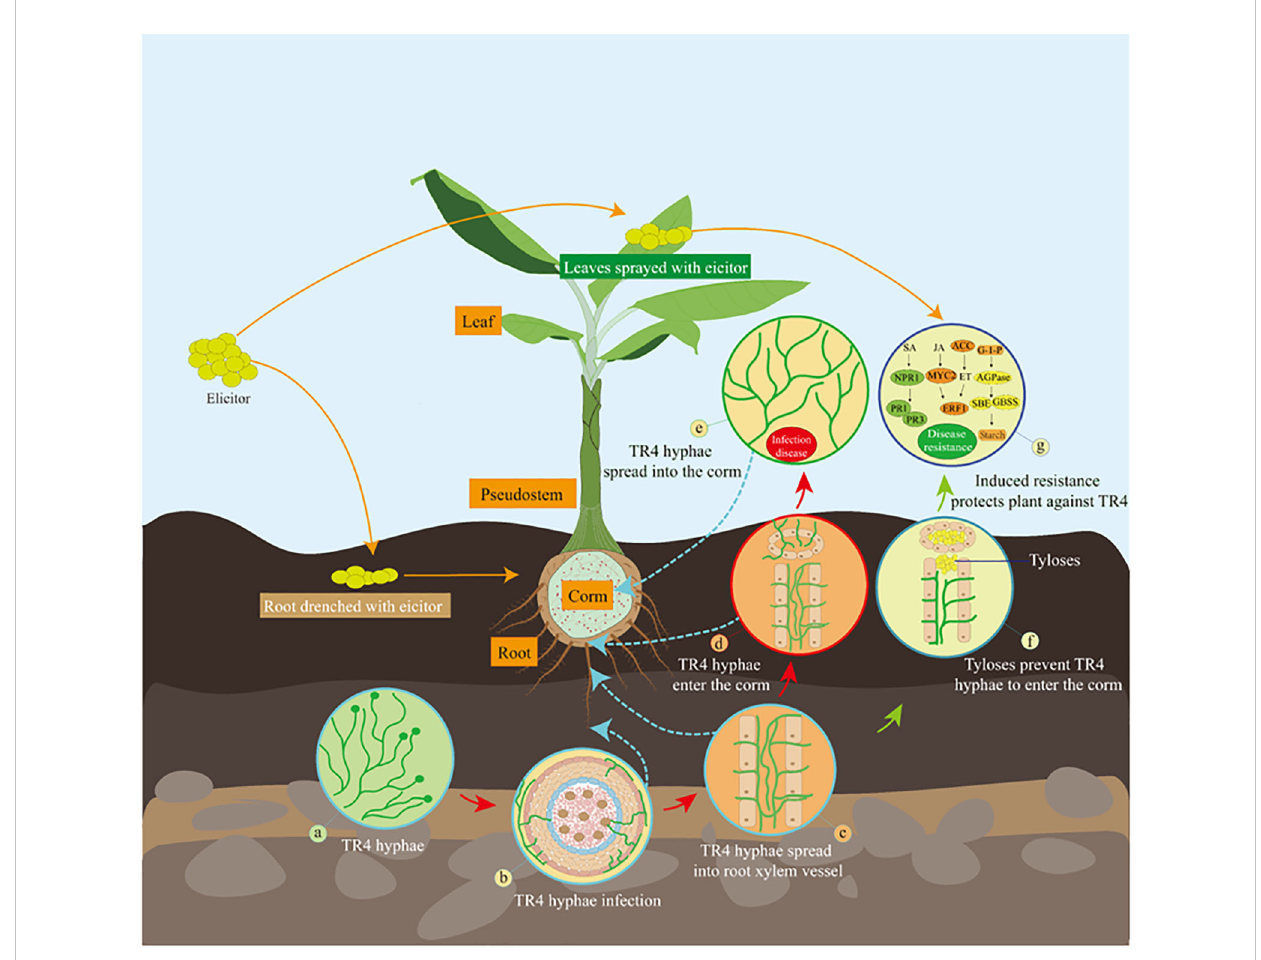
FIGURE 1 Scheme illustrating that isotianil-induced multi-resistance in bananas to prevent TR4 infection. (A) TR4 hyphae in the soil; (B) TR4 hyphae are accumulated in the rhizosphere and infestation into the plant; (C) TR4 hyphae enter plant root xylem vessel and spread further; (D) TR4 hyphae spread into the xylem vessel that connects the root to the corm; (E) TR4 hyphae spread into the corm and multiplies; (F) TR4 hyphae is blocked to enter the corm by elicitor -induced tyloses in the xylem vessel connecting the root to the corm; (G) After elicitor applicated plants by drenching roots or spraying leaves, multiple defense systems in the banana plant are activated to prevent further spread of TR4 in the corm. SA, salicylic acid; NPR1 , nonexpressorofpathogenesis-relatedgenes1; PR1 , pathogenesis-related 1 genes; PR3 , pathogenesis-related 3 genes; JA, jasmonic acid; MYC2 , basic helix-loop-helix transcription factor; ERF1 , ethylene response factor 1; ET, ethylene; ACC , 1-aminocyclopropane-1-carboxylic acid synthase; AGPase , ADP-glucose pyrophosphorylase; SBE, Starch branching enzyme; GBSS , granule-binding starch